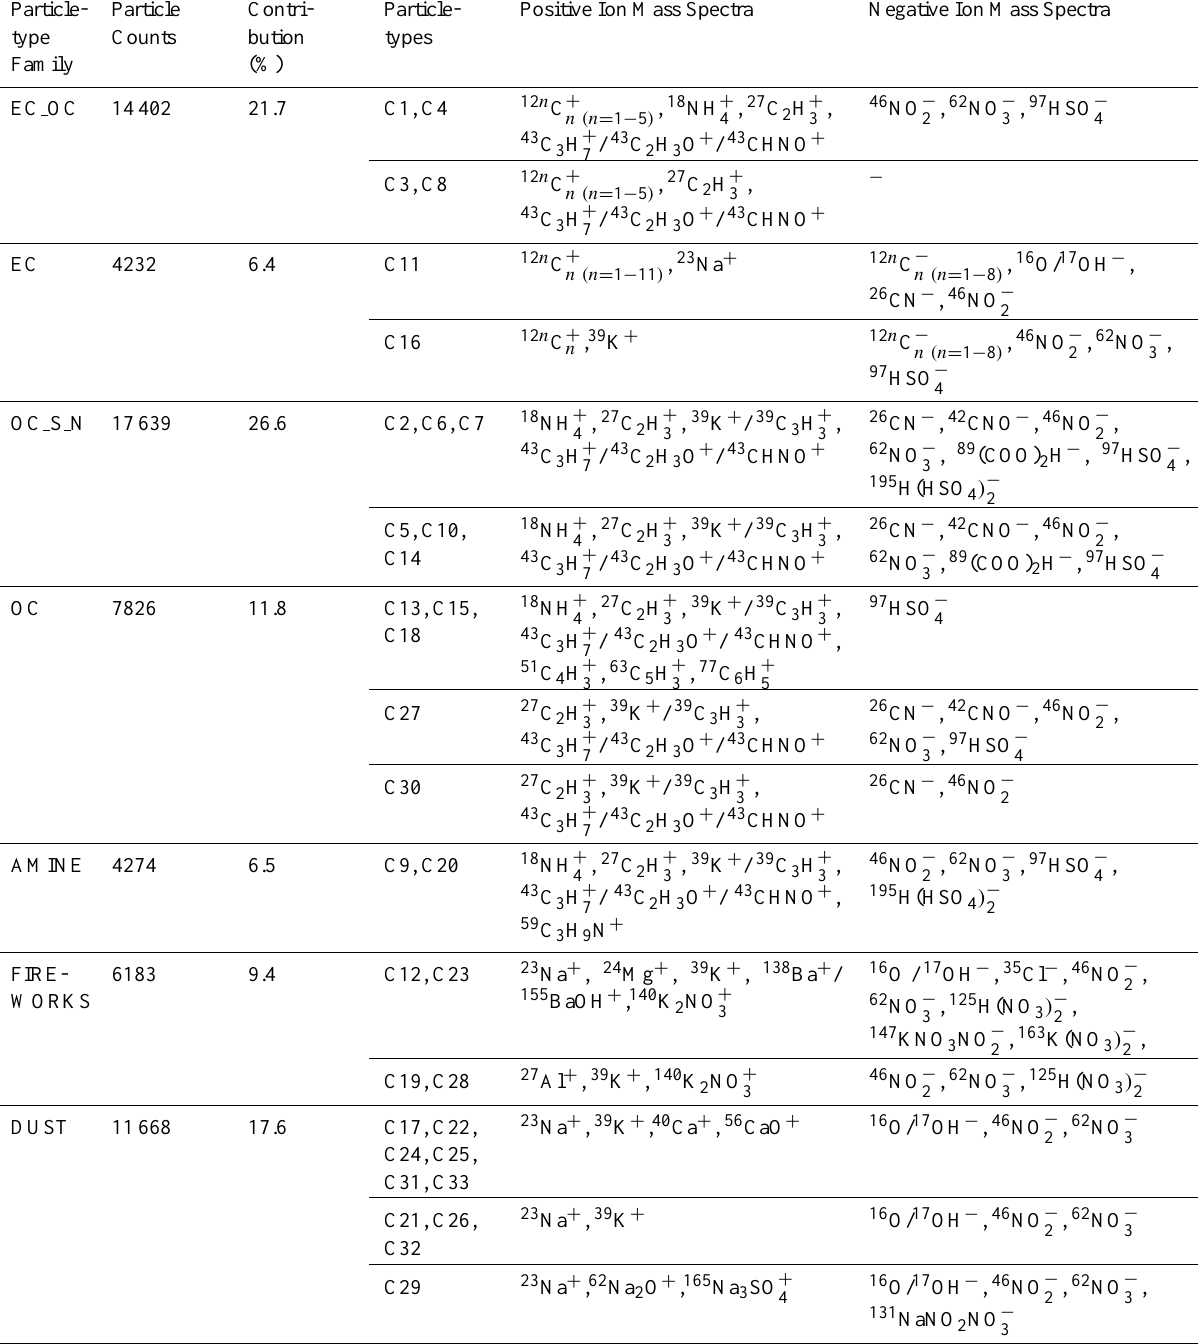
Table 1. Particle counts and major ions describing each particle-type and their corresponding families for the top 33 ATOFMS particle-types. The details of each of the C1-C33 particle-types are provided in the Supplement, including Figs.